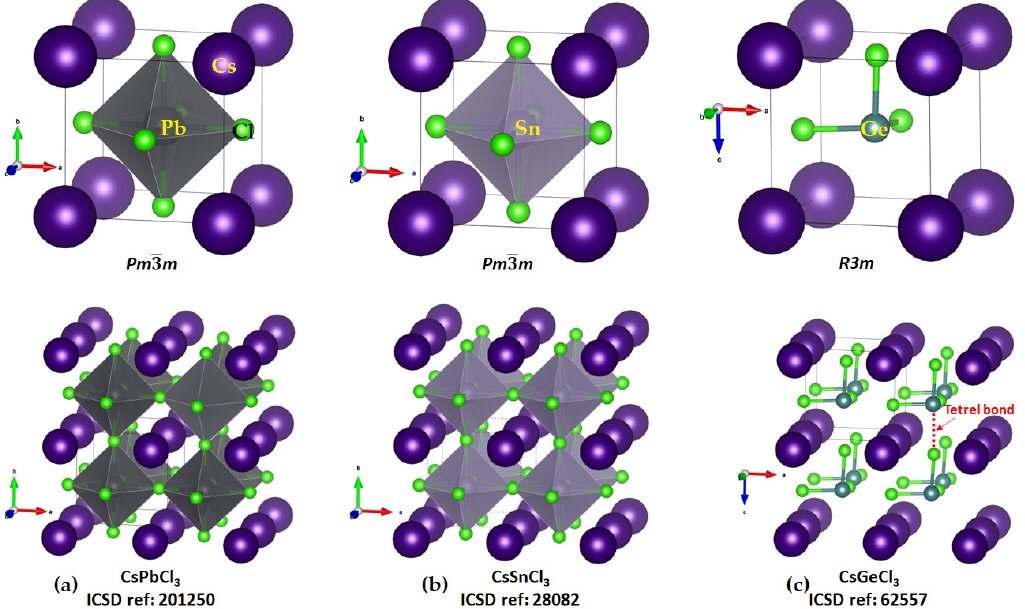
Figure 8. ( a – c ) Top: the polyhedral models of the unit cells of the crystals of CsTtCl 3 (Tt = Ge, Sn, and Pb). Bottom: illustration of the polyhedral models of the 2 × 2 × 2 supercell structures of these crystals, showing their cage-like structures. ICSD references and point groups are depicted in each case. The nature of the tetrel bond is marked in the structure of CsGeCl 3 (bottom,